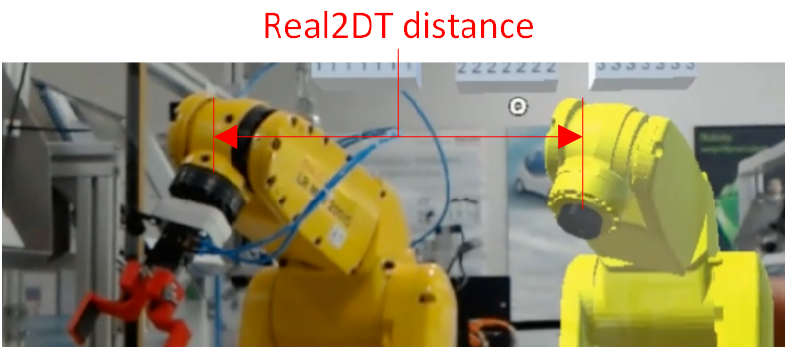
Figure 12. Visualization of the measurement between a real point and the corresponding point on the virtual representation of the robot (Real2DT).